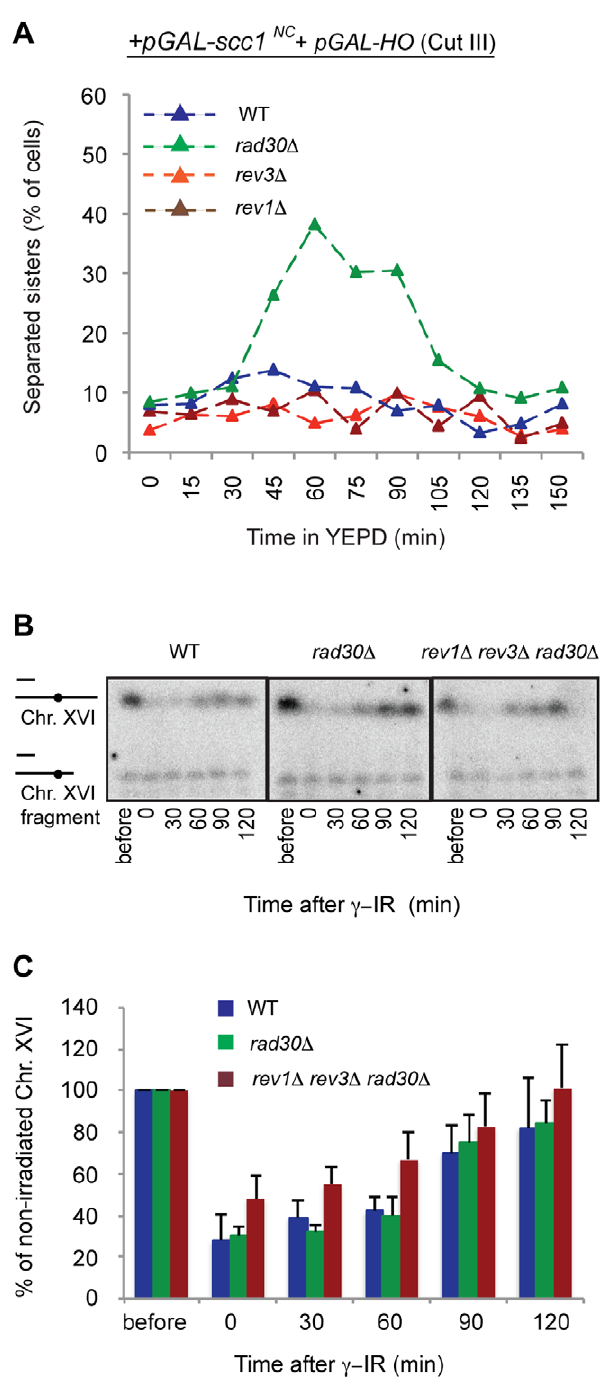
Figure 4. Establishment of DI-cohesion is a function unique for Pol g among the TLS polymerases. (A) Using the Scc1 NC system (Figure 1E), establishment of DI-cohesion was compared between WT, rev1 D , rev3 D or rad30 D deletion mutants. One DSB at the MAT locus on Chr. III was induced by pGAL-HO . Percentage of separated sister chromatids were scored in $ 200 cells per time point by the TetR-GFP/ Tet-O-system (see Figure 1). (B) Determination of DSB repair during G2 in a triple TLS polymerase deletion strain by PFGE (See Figure 2A for details). (C) Averaged quantifications of pulsed field gels run on the indicated strains (See Figure 2B for